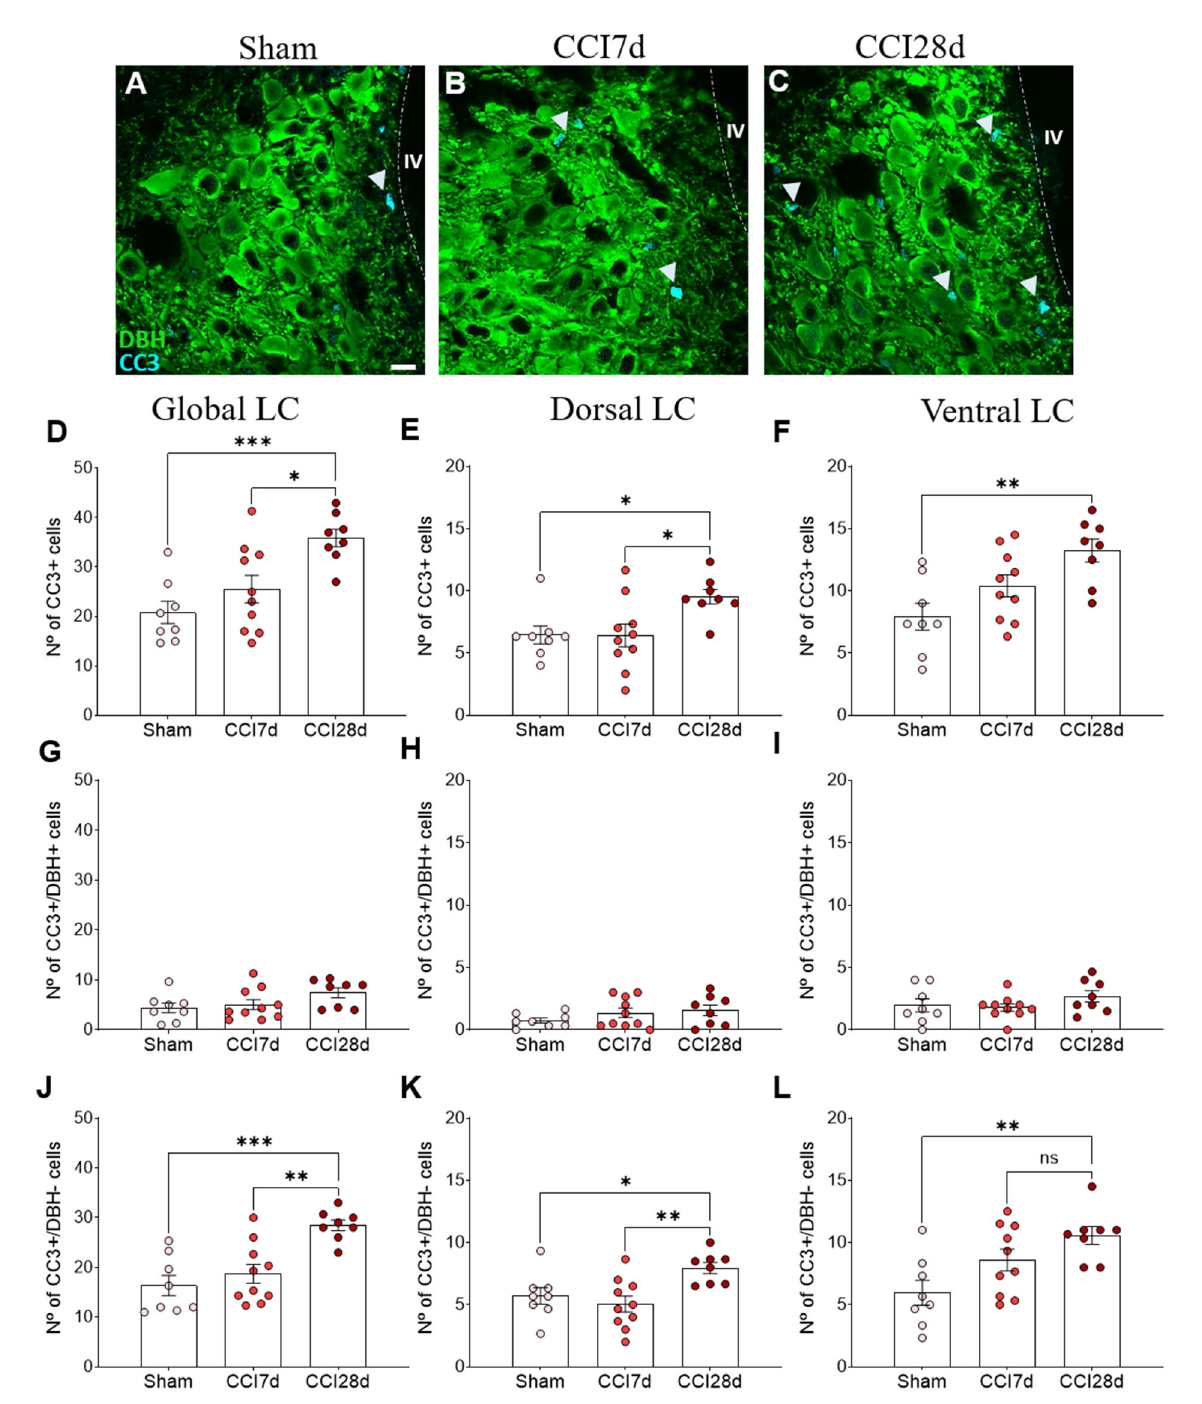
FIGURE6 Cell damage in the LC of neuropathic pain rats. (A–C) Representative confocal images of CC3 expression in DBH + neurons of the LC in (A) Sham, (B) CCI7d, and (C) CCI28d rats (DBH green, CC3 blue: scale bar, 10 µ m). (D–F) Quantification of the number of CC3 + cells in the (D) global, (E) dorsal, and (F) ventral LC. (G–I) Quantification of the number of CC3 + /DBH + cells in the (G) global, (H) dorsal, and (I) ventral LC. (J–L) Quantification of the number of CC3 + /DBH − cells in the (J) global, (K) dorsal, and (L) ventral LC. The data are presented as the mean ± SEM of the number of CC3 + cells (obtained from three to four quadrants in a total of three LC sections per rat): * p < 0.05, ** p < 0.01, *** p < 0.001 vs. the indicated group, one-way ANOVA followed by a Tukey’s